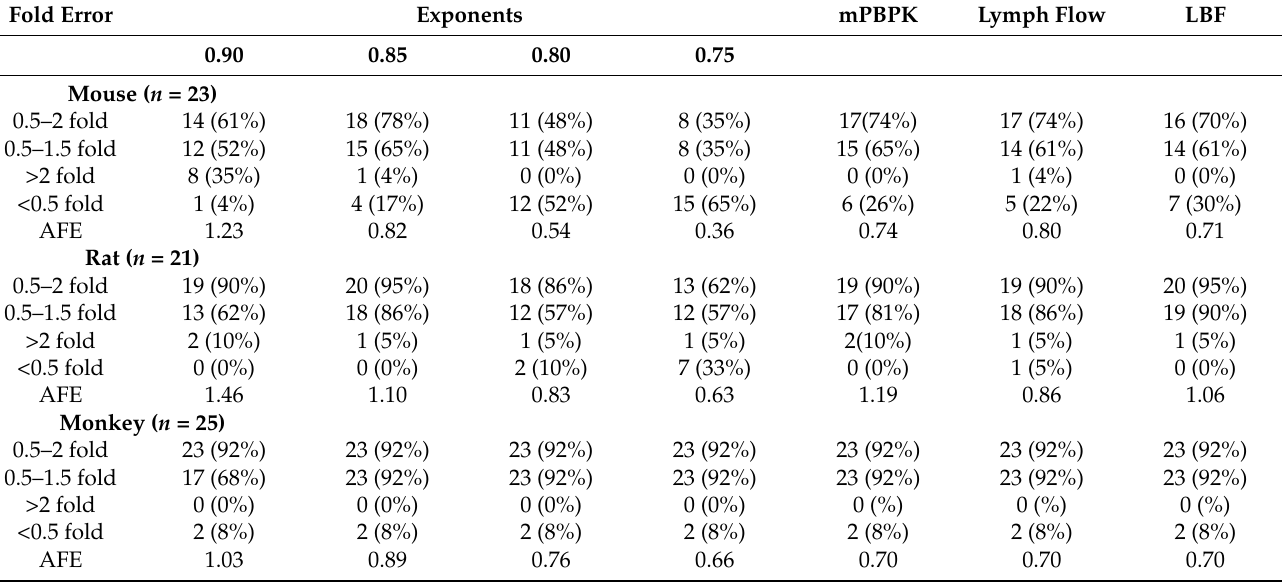
Table 2. Prediction of human clearance from preclinical species by different